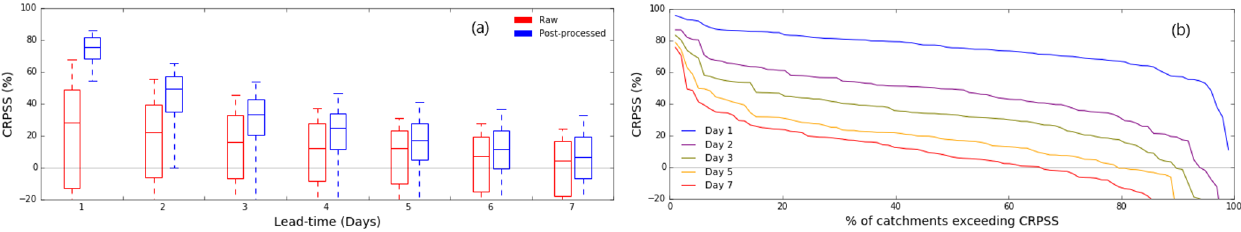
Figure 9. (a) CRPSS (%) of streamflow for raw and ERRIS-corrected forecasts, and (b) percentage of forecast locations (total 100) exceeding CRPSS (%) for ERRIS-corrected streamflow forecasts for different lead times.